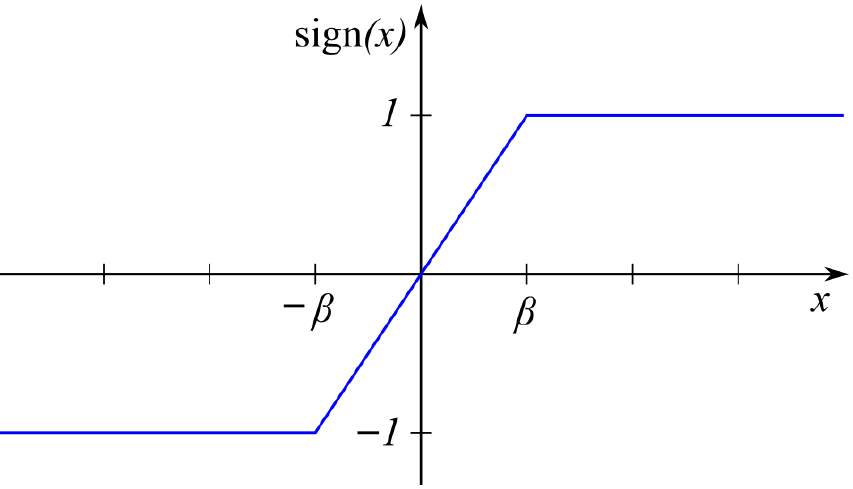
Figure 8. Sign function adopted in the simulation code.